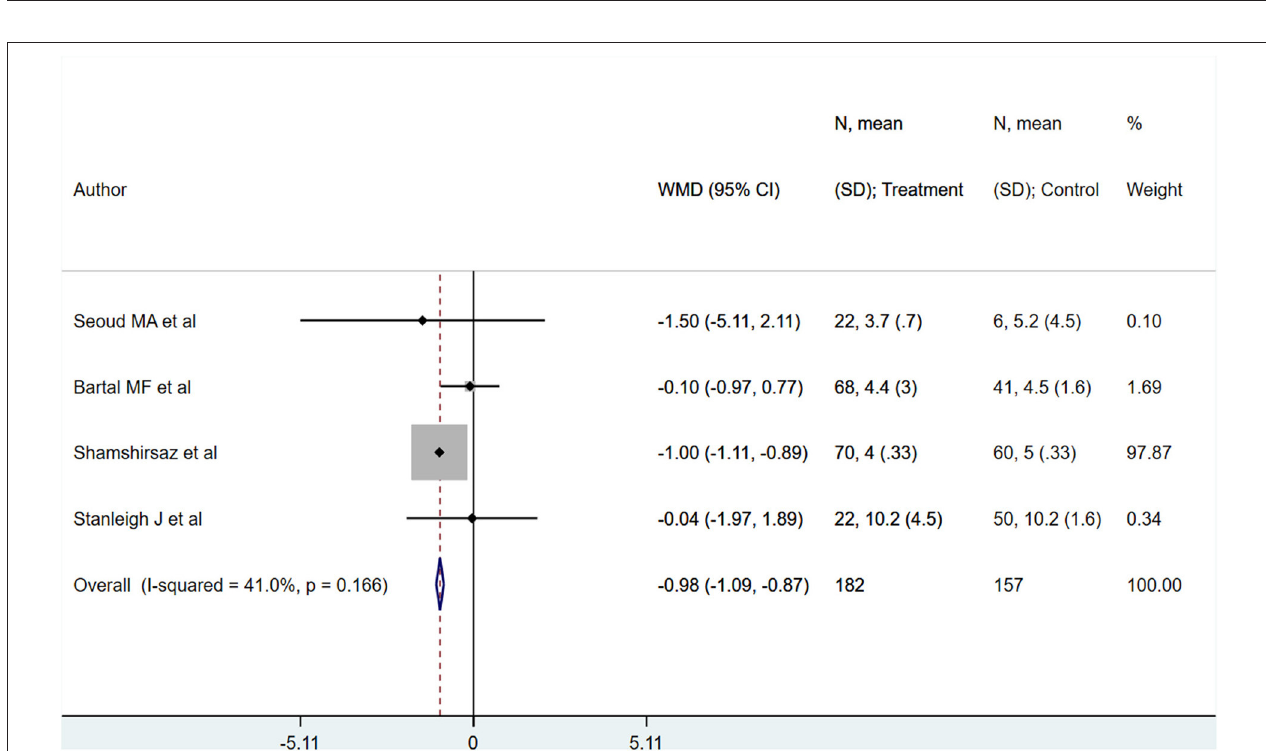
FIGURE 6 | Duration of hospital stay for PAS patients undergoing planned or emergency delivery.